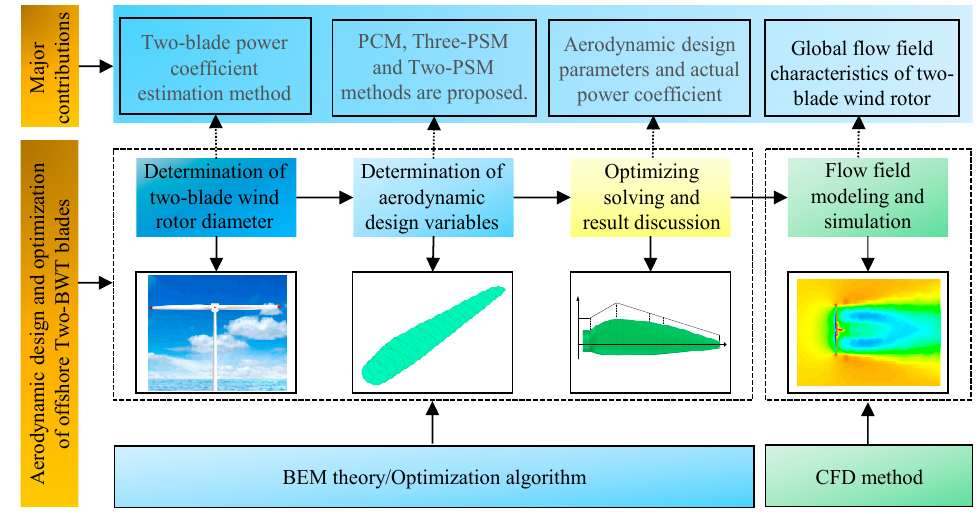
Figure 1. Research flow of the Two-BWT blade design.